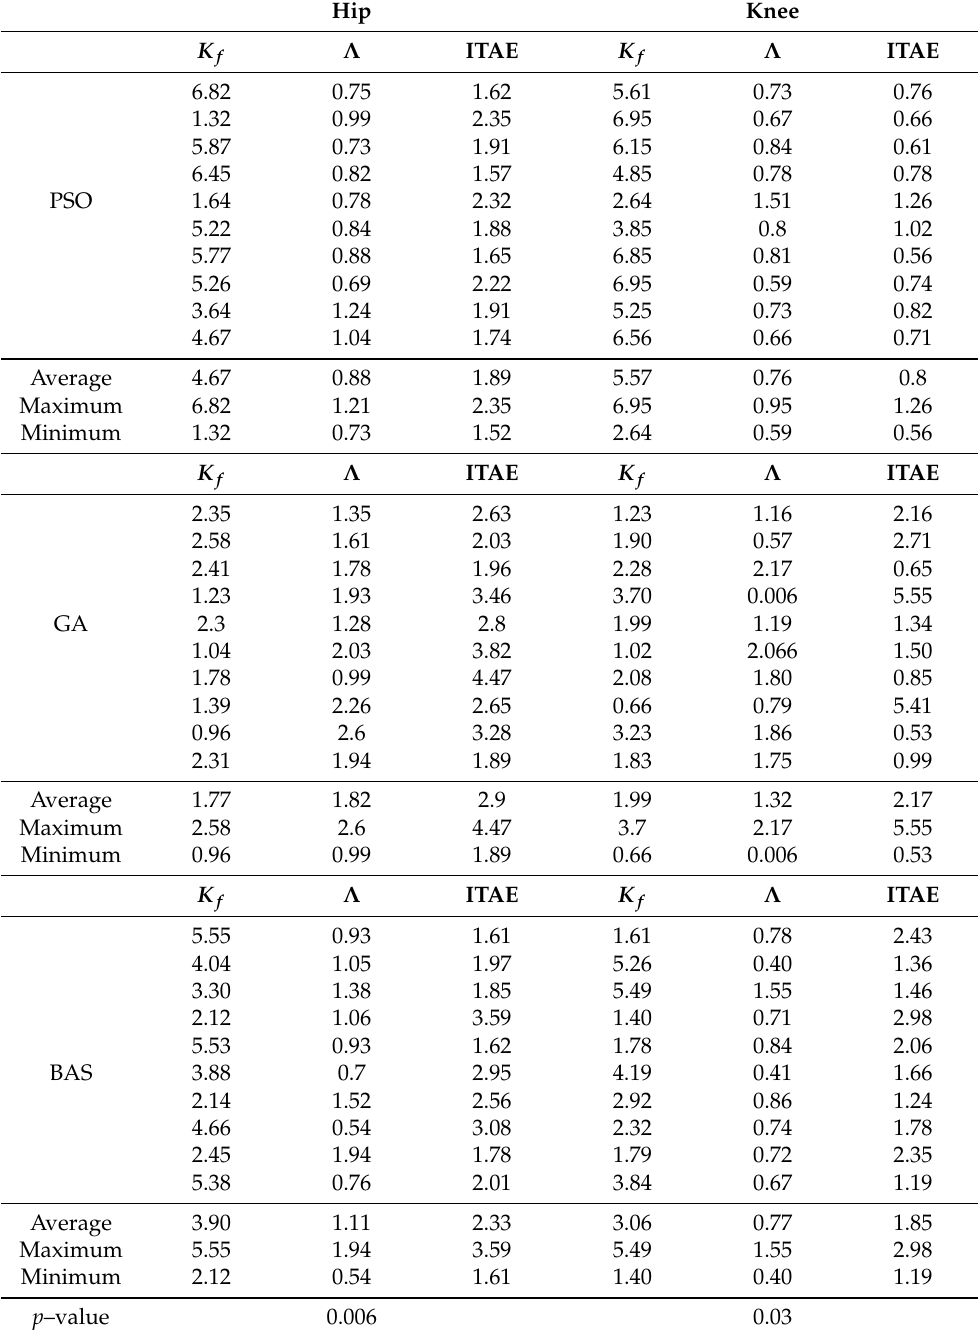
Table 3. Numerical analysis of PSO, GA, and BAS for